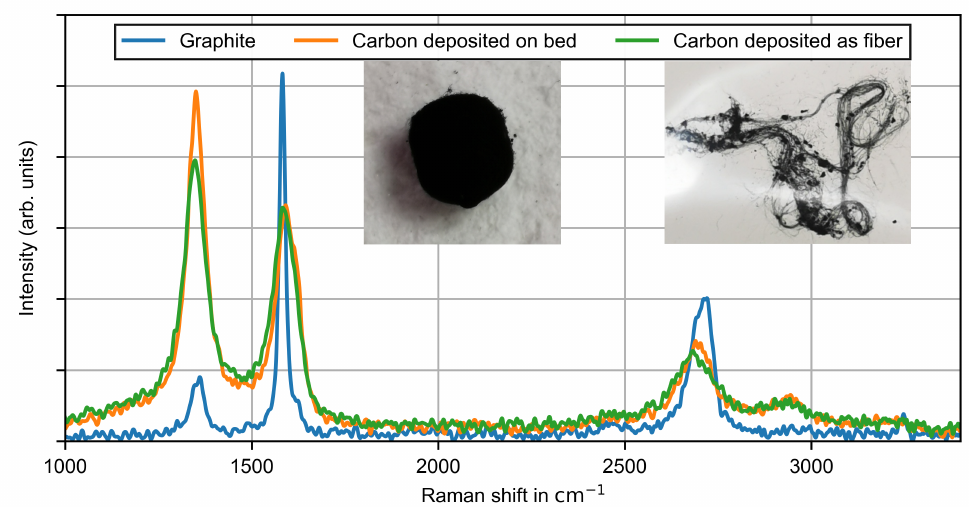
Figure 9. Raman intensity plots of carbon samples deposited on the ceramic bed material and in the void space as fibers. Carbon samples were produced during a thermal decomposition measurement at 1300K and varying gas flow rates of pure